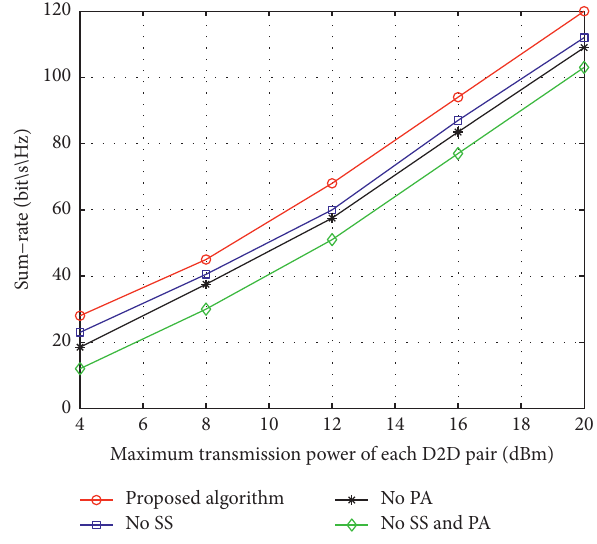
Figure 4: All D2D users sum rate for different maximum trans- mission power of each D2D pair.